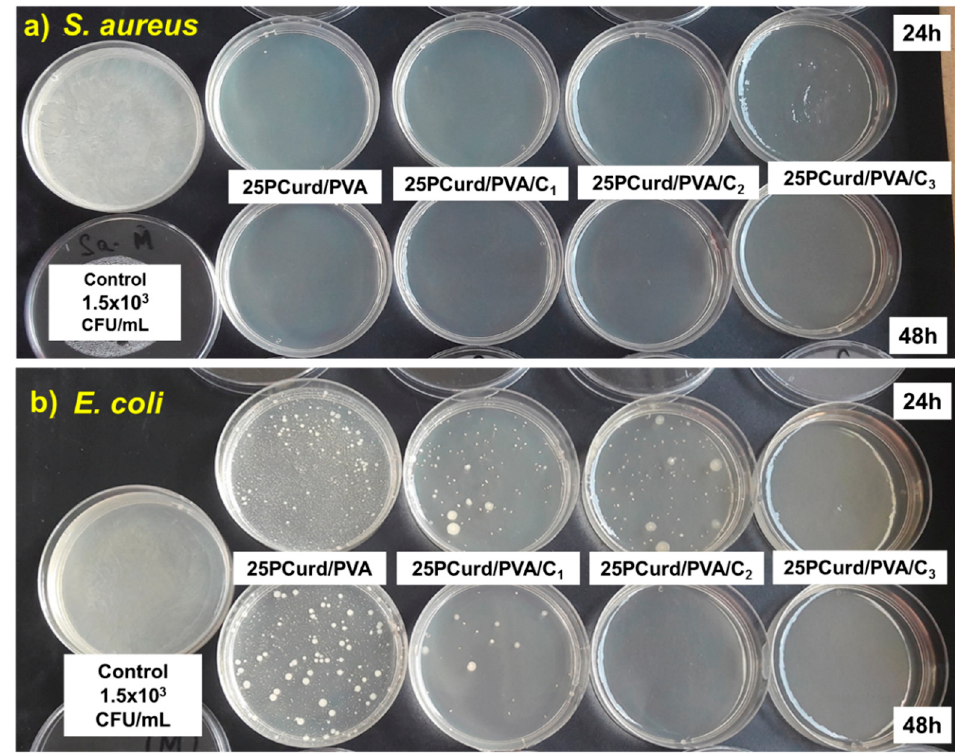
Figure 7. Time-kill assay test of PCurd/PVA samples with and without CEO against S. aureus ( a ) and E. coli ( b ).